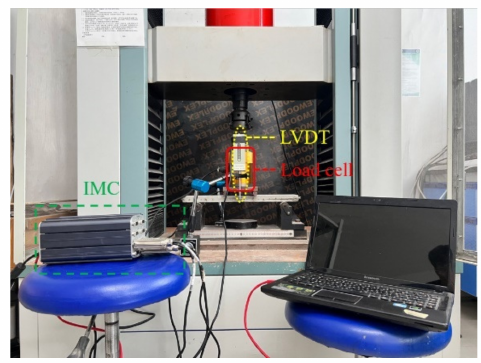
Figure 4. Four-point bending test of BTRC